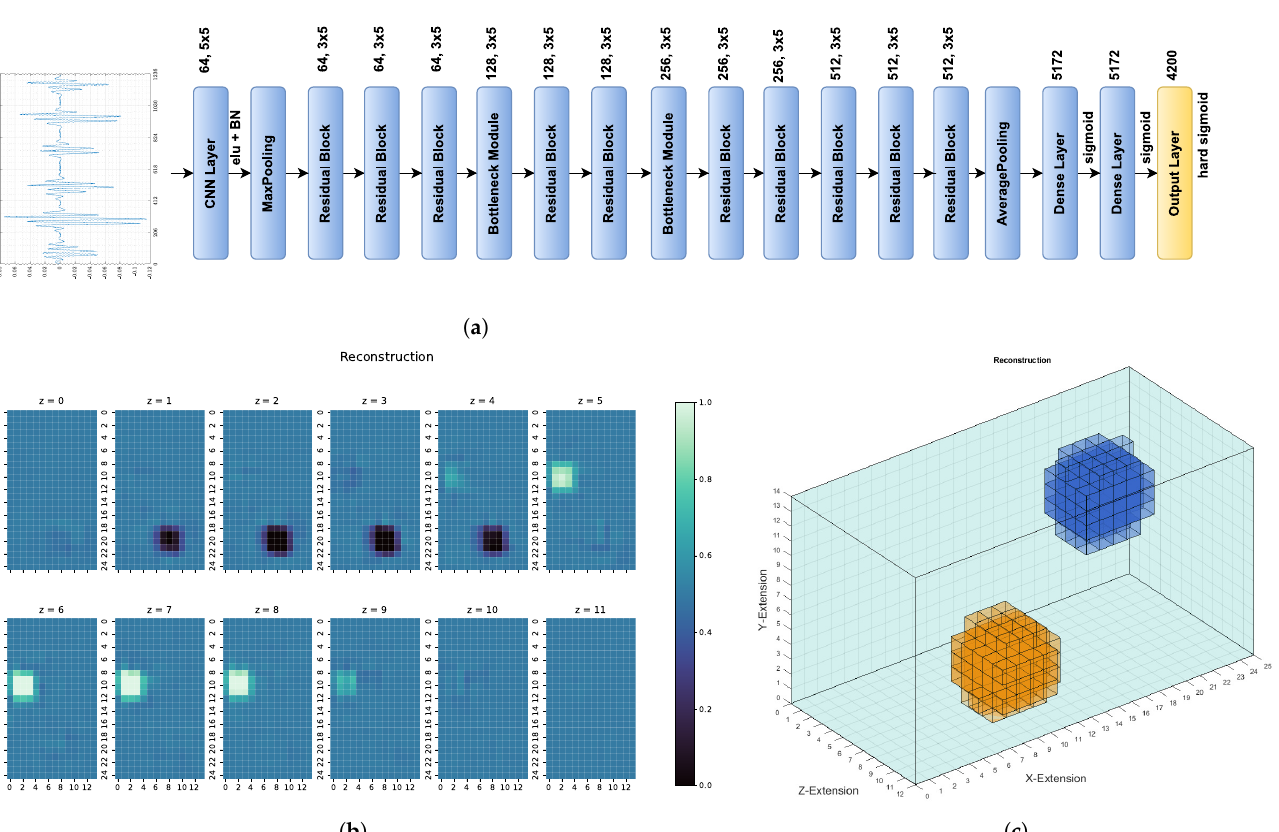
Figure 5. ( a ) Structure of theused ResNet. On the left is a typical differential signal, which is transformed into the 2D input and then used to reconstruct the conductivity distribution. ( b ) 2D reconstruction of the conductivity distribution by ResNet based on the differential signals, as shown in ( a ). ( c ) The same conductivity distribution reconstruction as in ( b ), only shown as 3D